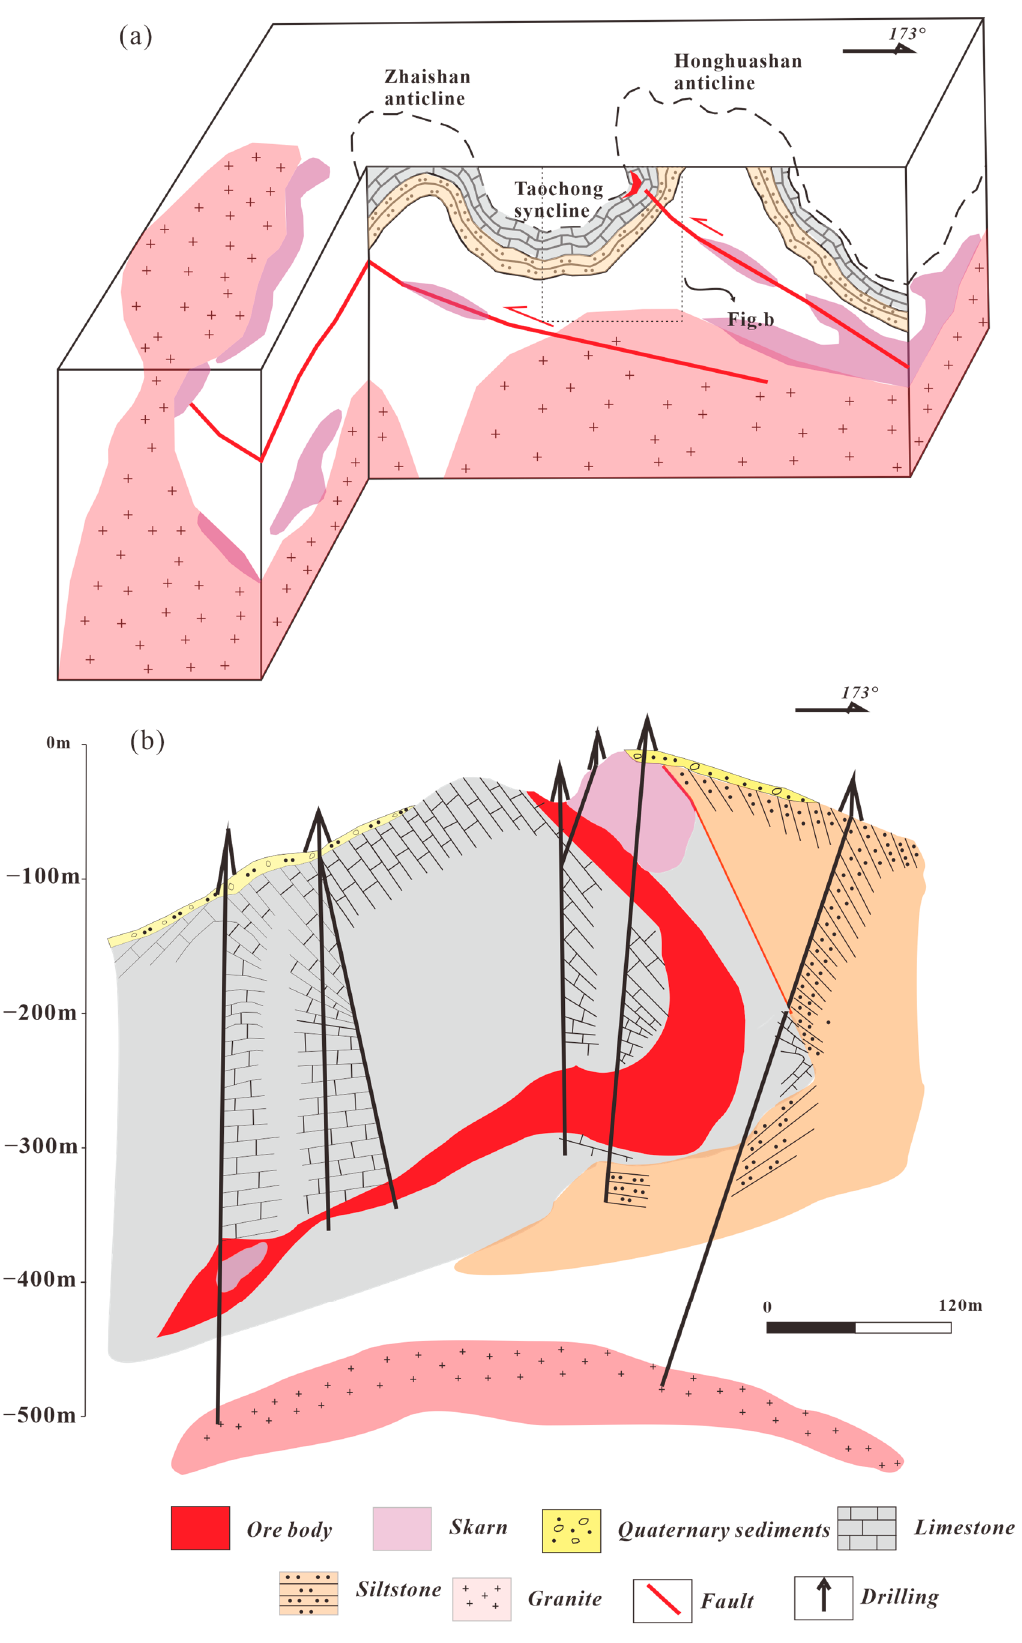
Figure 10. ( a ) Three-dimensional metallogenic model map (modified from [165]); ( b ) profile of the Taochong iron mine in the FVB (modified from [164]).